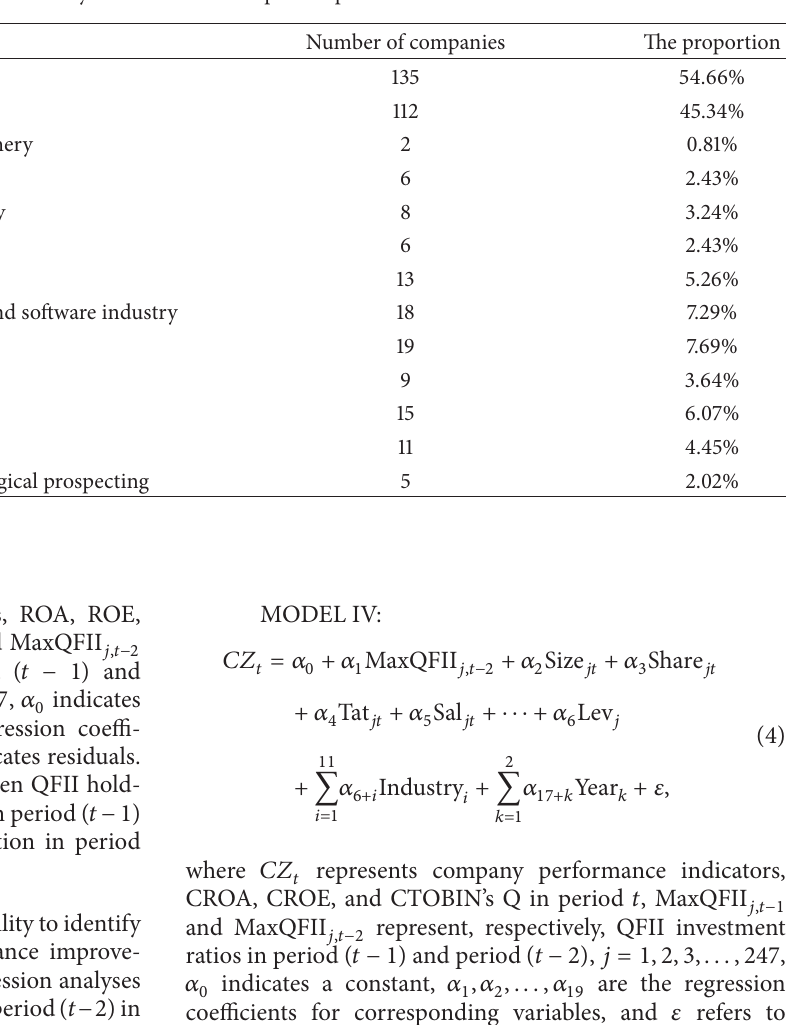
Table 2: Industry distribution of sample